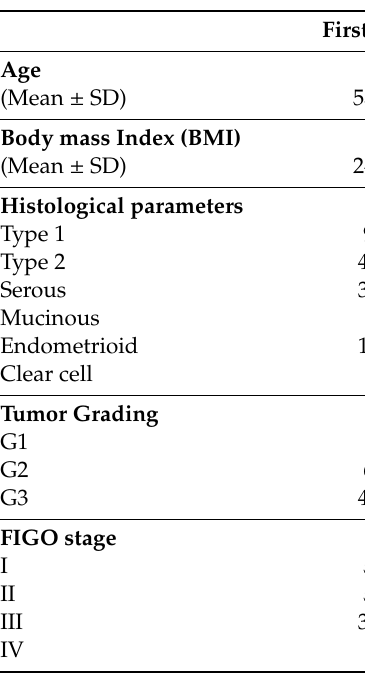
Table 1. Clinical and surgical parameters in our patients at first diagnosis and